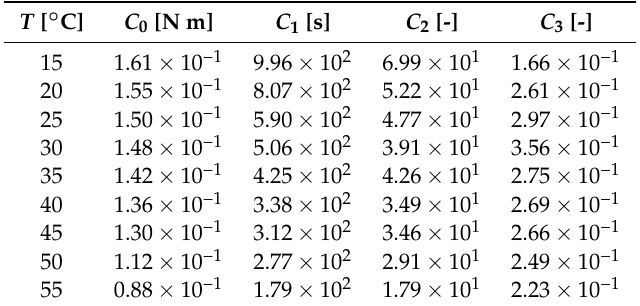
Figure 3. Curing behavior of adhesive SikaFast 5215 NT and approximation. Table 1. Fitting coefficients C i of Equation (2) for different temperature sets.